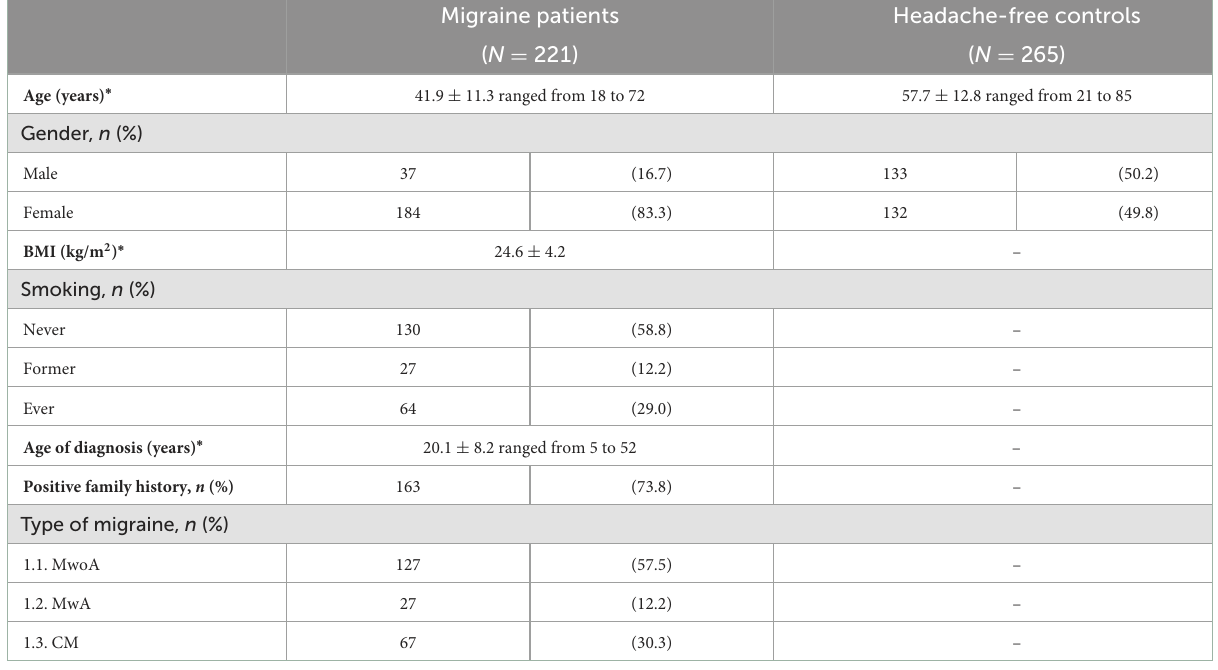
TABLE 2 Demographic and clinical characteristics of the study population.